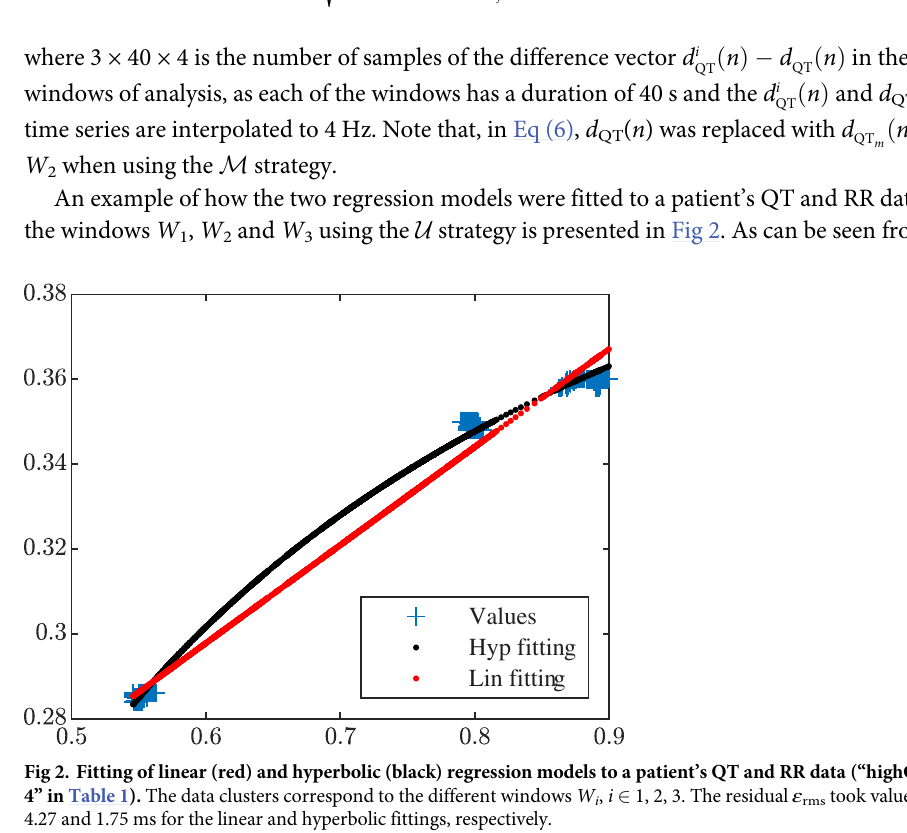
, i 2 1, 2, 3. The residual ε rms took values of i